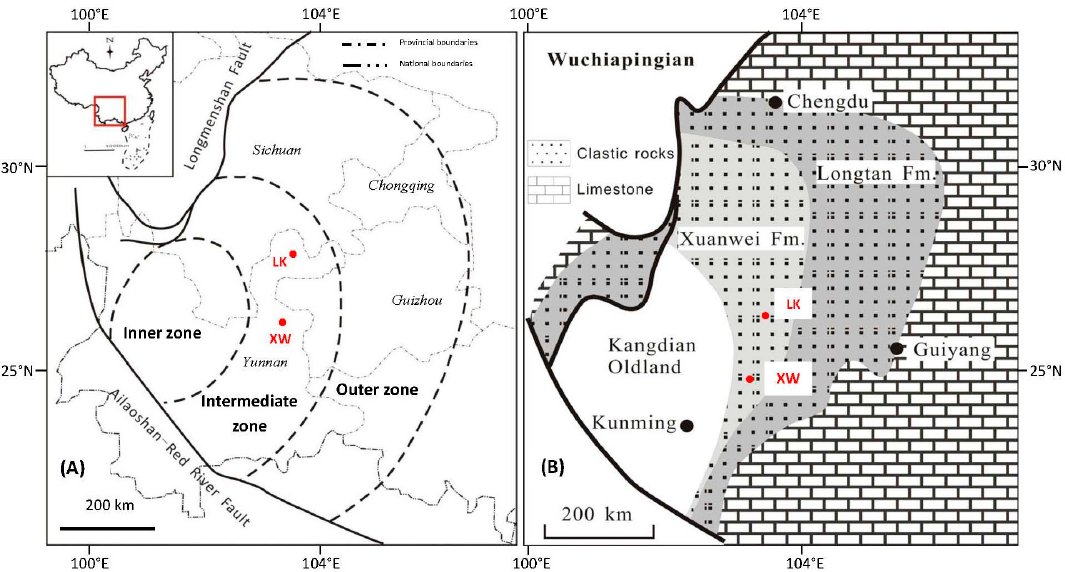
Figure 1. Geological setting during Late Permian in southwest China, showing the location of Nb-Zr-REE-Ga mineralization. ( A ) Schematic map showing the inner, intermediate and outer zones of the Emeishan Large Igneous Province. ( B ) Paleogeography map showing the distribution of terrestrial Xuanwei Formation and transitional Longtan Formation during the Wuchiapingian in SW China. The red spots indicate the localities of the two studied drill holes (XW and LK). Figure 1 is modified from [20].